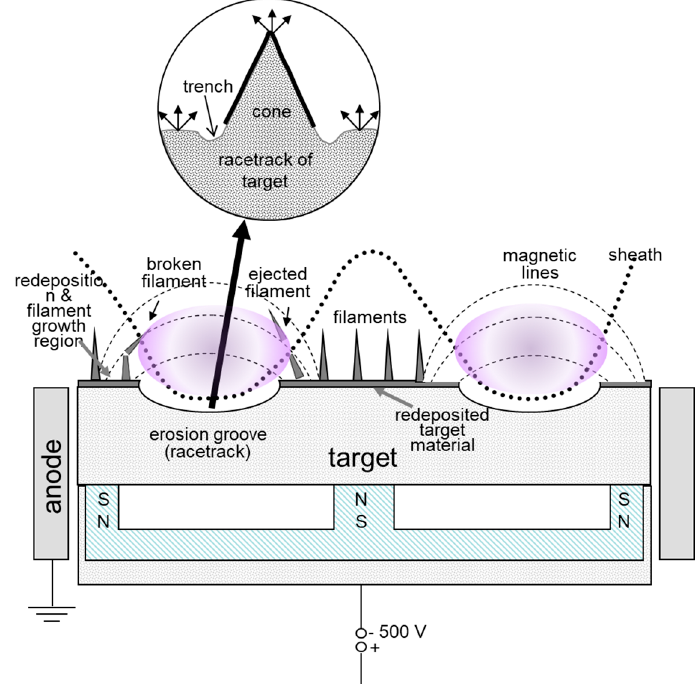
Figure 21. Scheme illustrates the formation and fracture of filaments on the perimeter and in the middle of the magnetron target surface. The cone formation on the racetrack of target is also schematically shown.